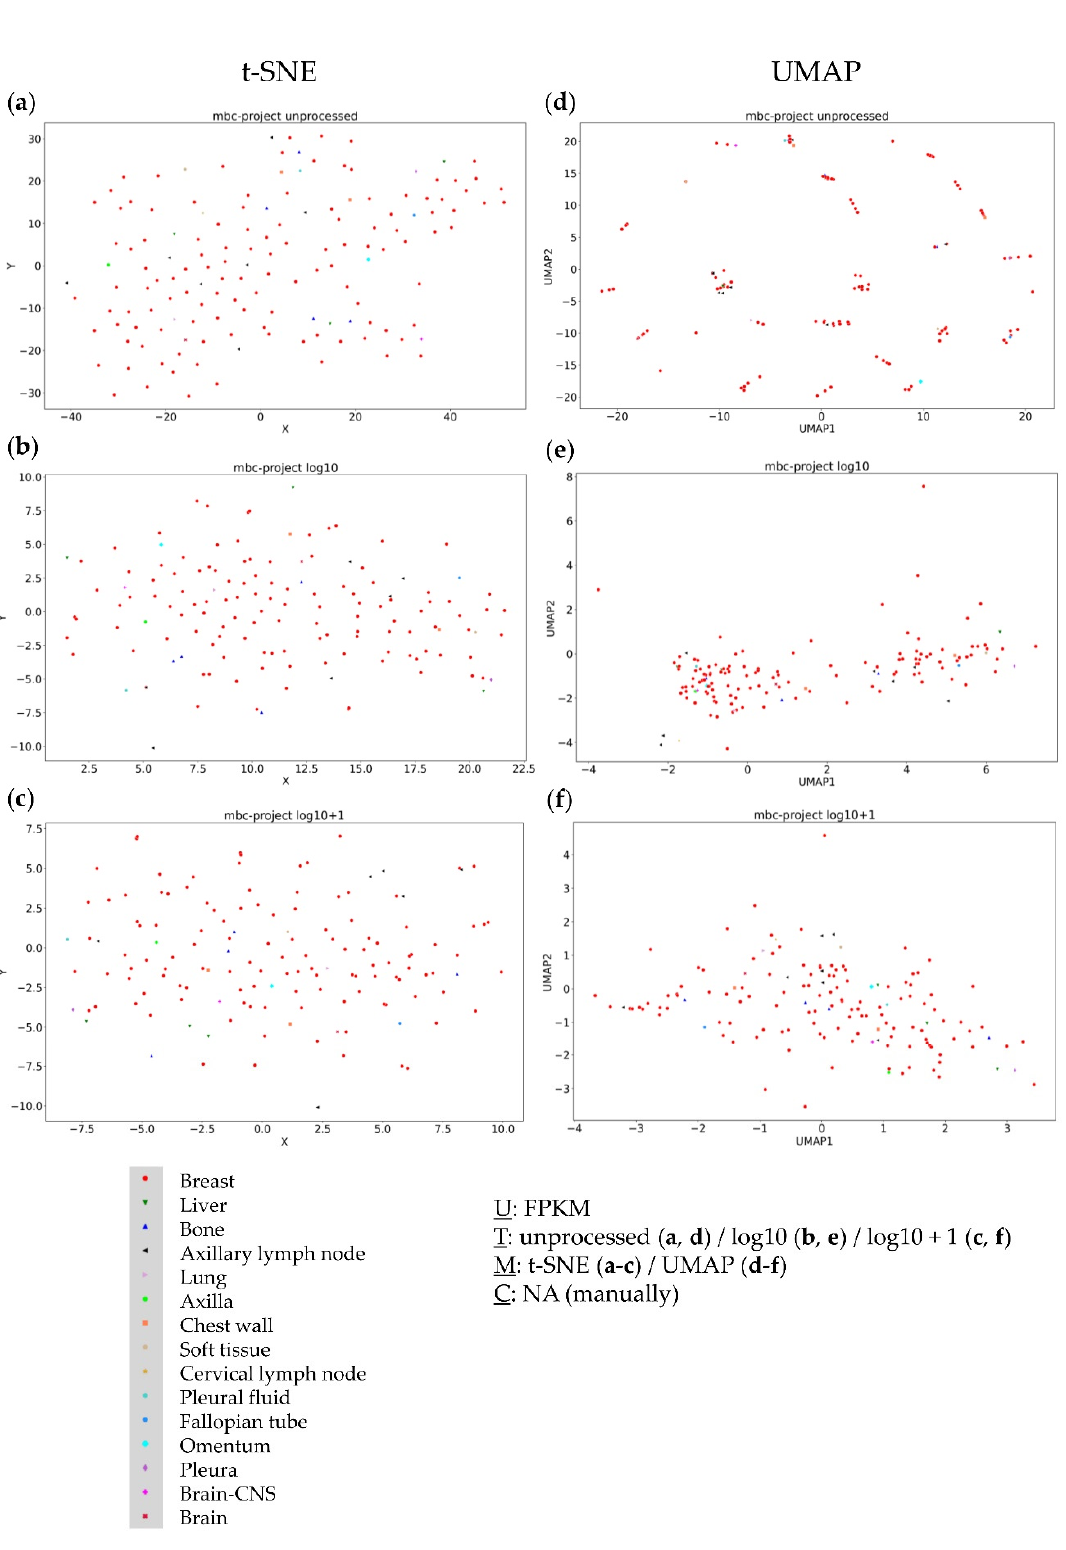
Figure 6. Visual clustering of the MBC Project dataset consisting of primary and metastatic breast cancer (with respective resection sites) by applying different data dimension reduction methods. t-SNE plot approach for ( a ) unprocessed, ( b ) log10 transformed, and ( c ) log10 + 1 transformed FPKM values and UMAP approach using ( d ) unprocessed, ( e ) log10 transformed, and ( f ) log10 + 1 transformed FPKM values. FPKM: Fragments Per Kilobase Million; U: unit, T: transformation, M: data dimension reduction method, C: clustering method, NA: not applicable.